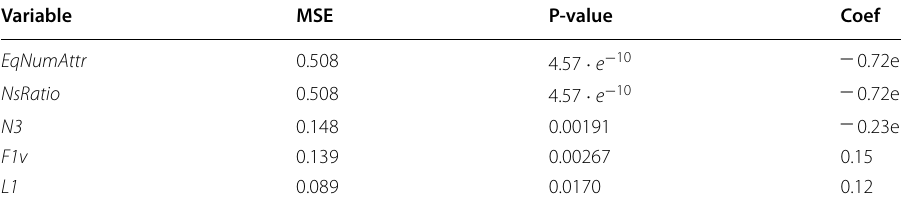
Table 2 The dataset properties that are significant when explaining the cost of comprehensibility using a number of standard dataset properties as independent variables in a regression model where the cost is the dependent